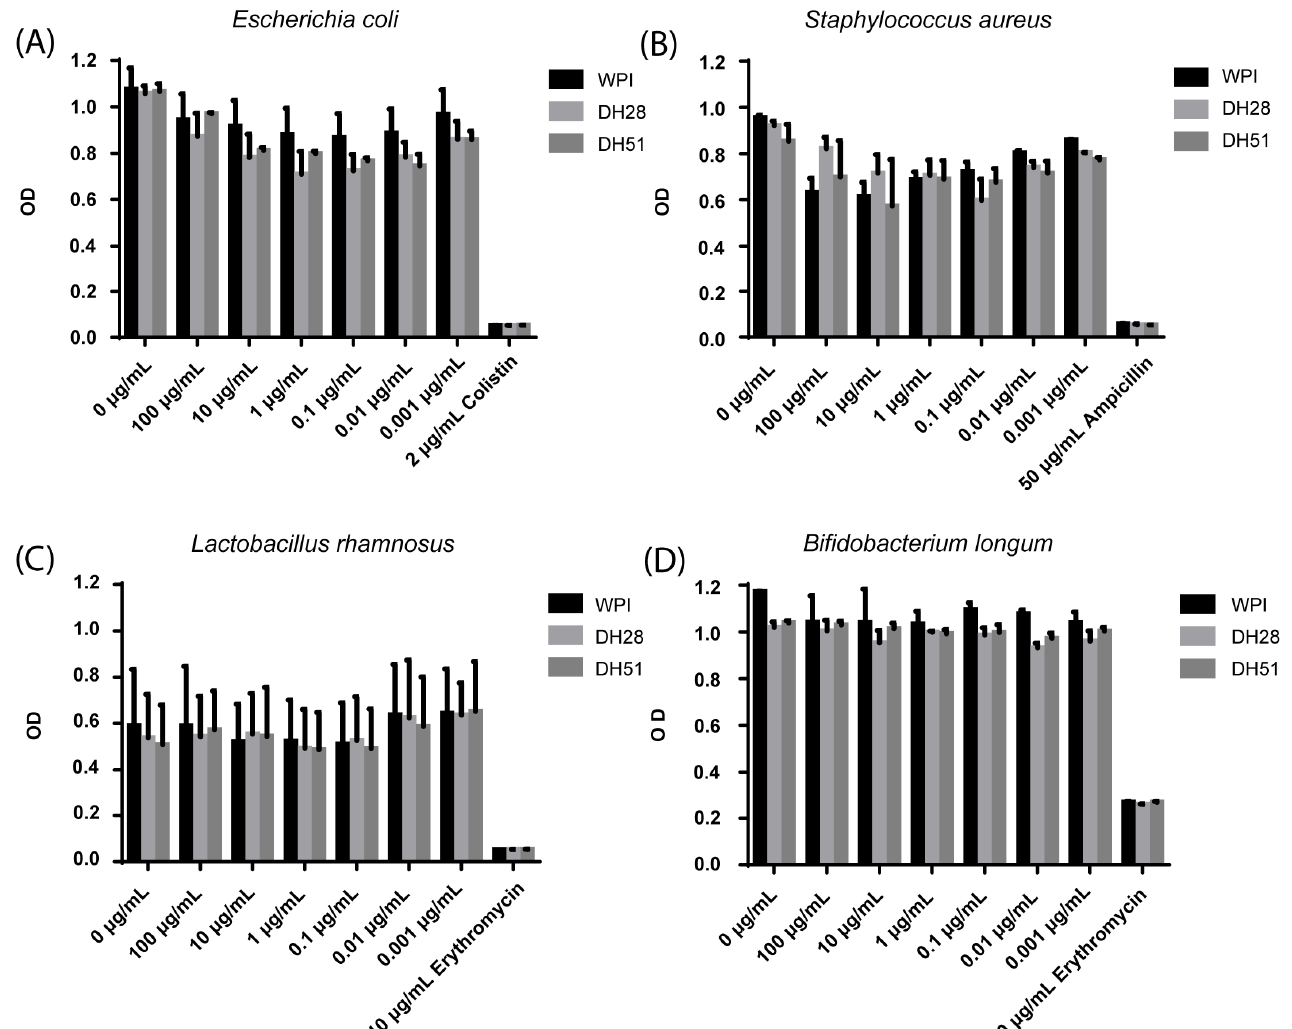
Figure 12. Absence of inhibition of growth of ( A ) Escherichia coli , ( B ) Straphylococcus aureus , ( C ) Lactobacillus rhamnosus and ( D ) Bifodobacterium longum by incubation with WPI, DH28, or DH51. Data are presented as mean and standard deviation of two independent measurements. Abbreviations: